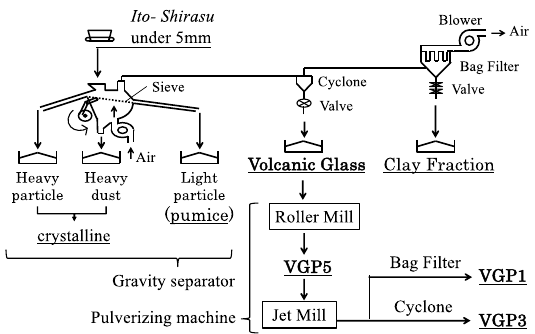
Figure 4. Manufacturing process of